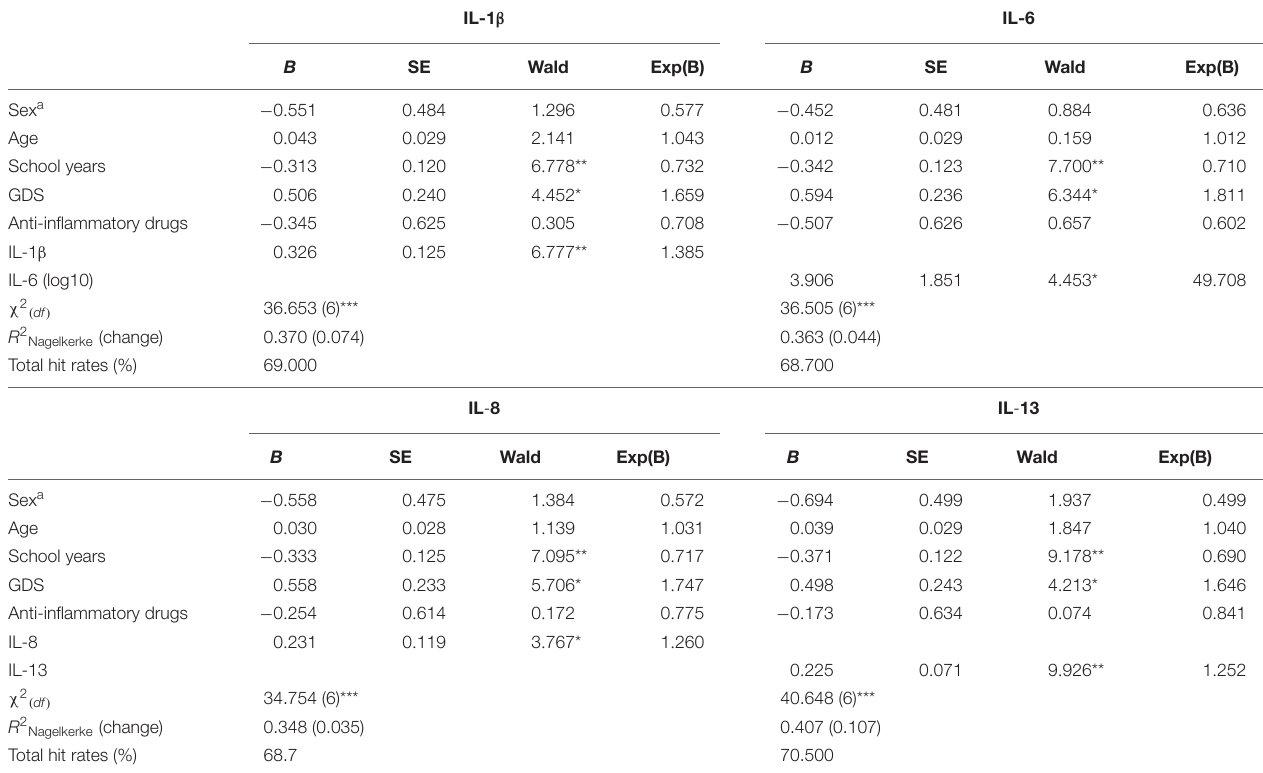
TABLE 4 | Binary logistic regression models to investigate the variables that discriminate between “Good” and “Poor” cognitive